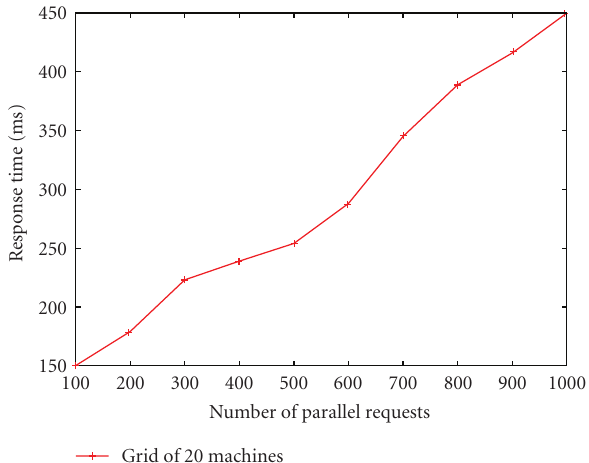
Figure 9: Response time (ms) for interzonal